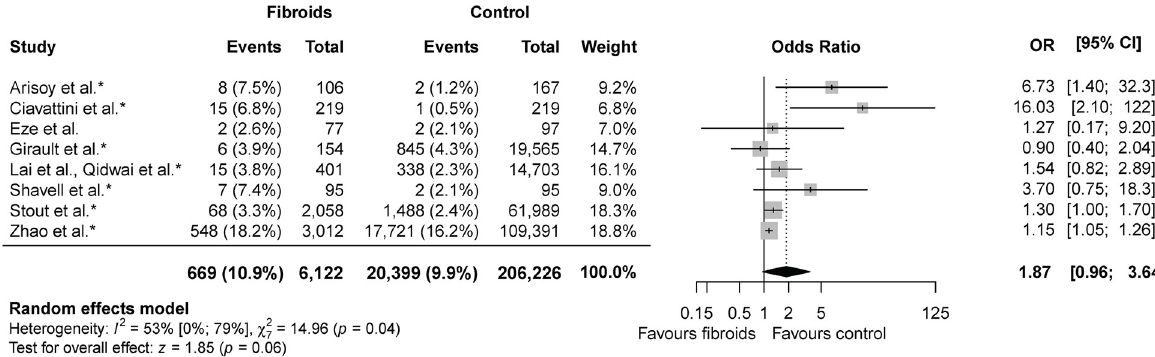
Fig 3. Meta-analysis PPROM. � indicates studies that corrected for potential